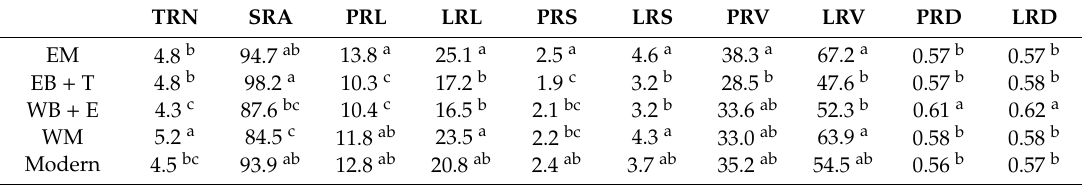
Table 2. Means comparison of seminal root system architecture traits measured in a set of 159 Mediterranean durum wheat genotypes structured into five genetic subpopulations [19]. Means within columns with di ff erent letters are significantly di ff erent at p < 0.01 following a Tukey test. TRN PRL